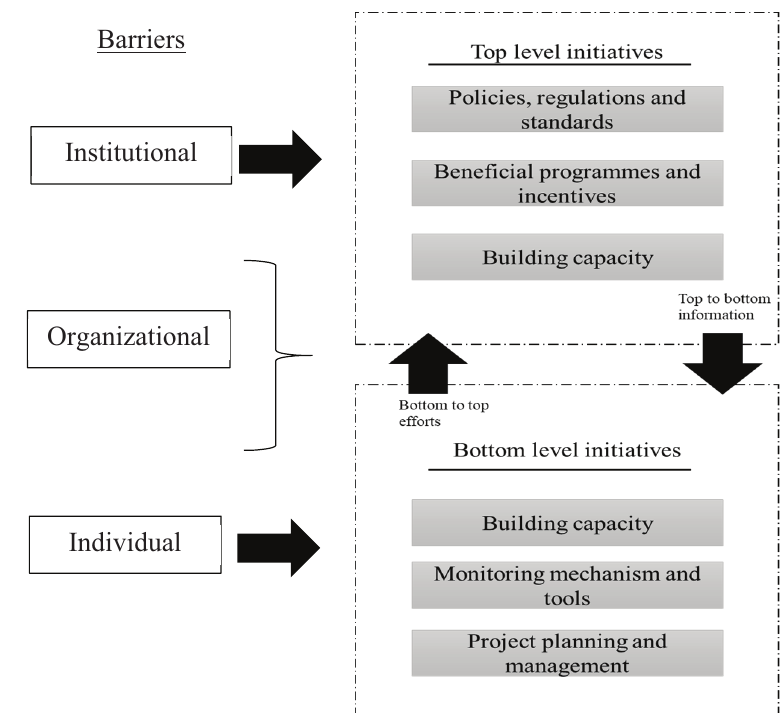
Emissions management strategies framework in the construction